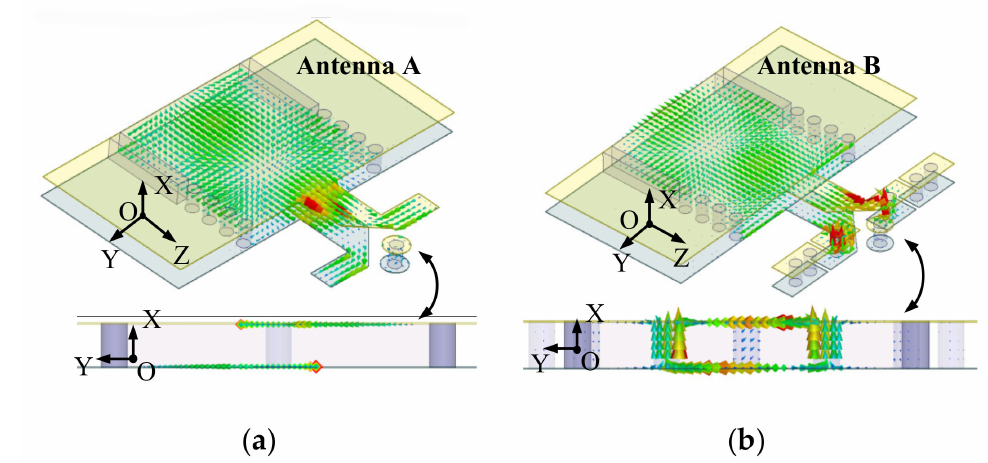
Figure 6. The surface electric current distribution for the two antennas at 45 GHz: ( a ) Antenna A, ( b ) Antenna